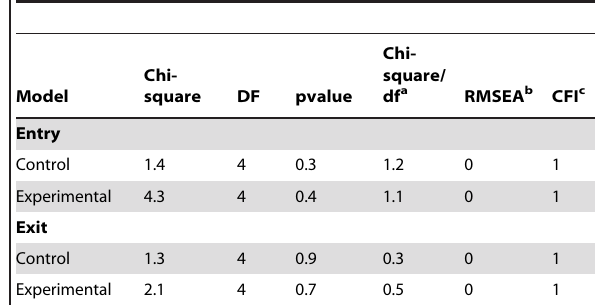
Table 3. Goodness of fit indices for the path analysis.